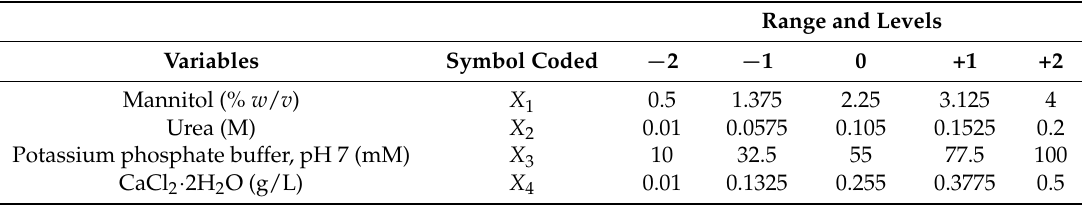
Table 2. Experimental range and levels of the independent variables used in